Question: Identify the chart type used in this figure.
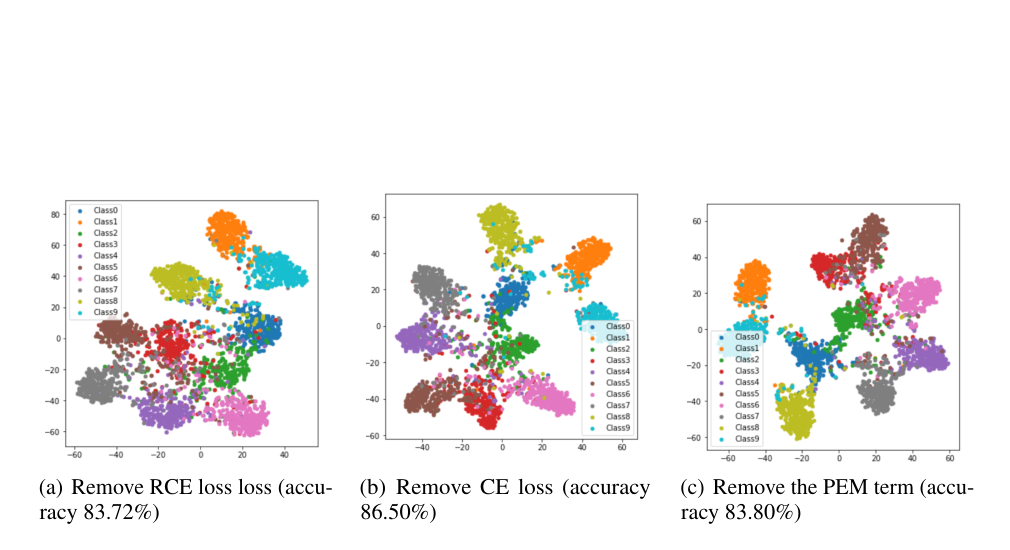
Answer: scatter